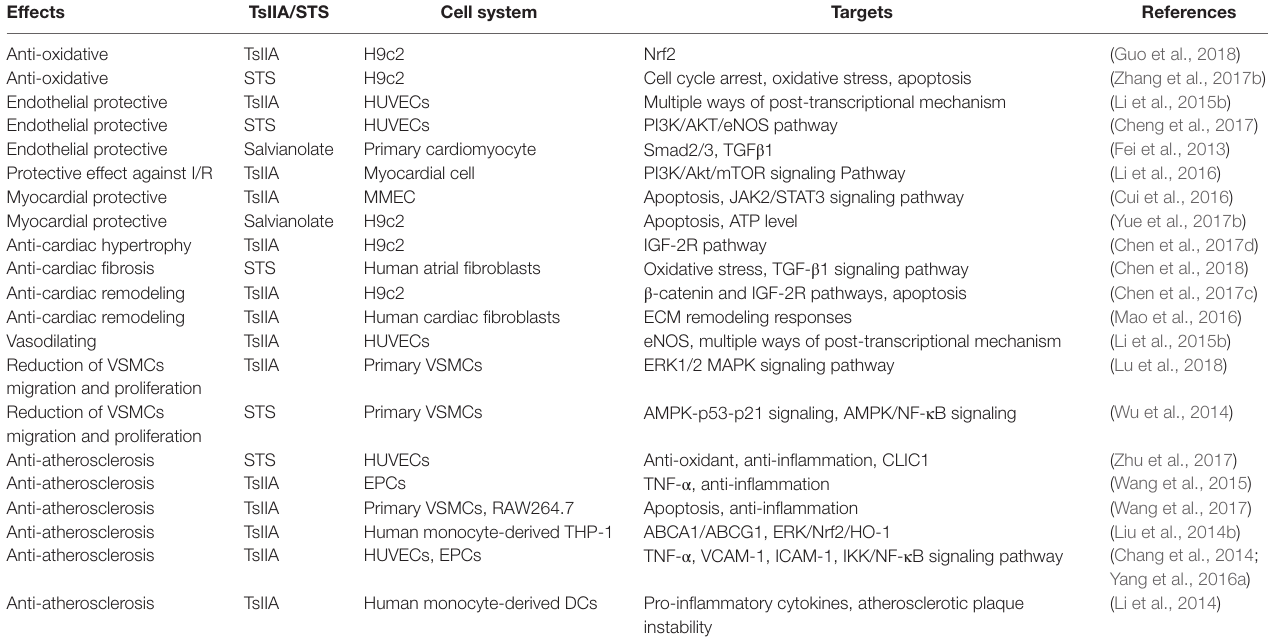
TABLE 1 | In vitro cardiovascular effects of TsIIA, STS and Salvianolate.